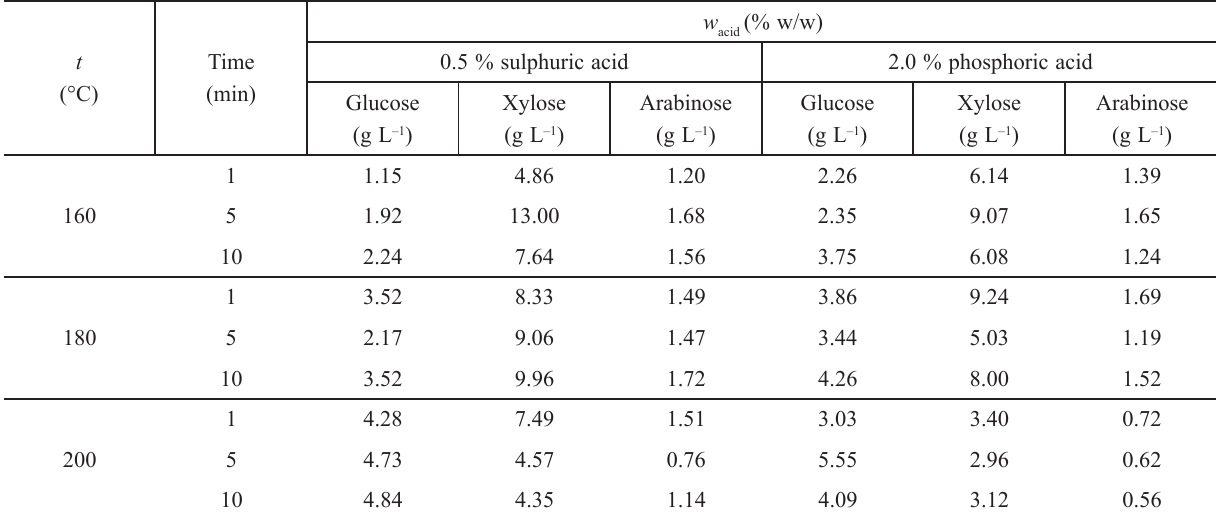
Table 1 – Concentrations of monomeric sugars in the liquor wheat straw hydrolysate after dilute acid pre-treatment in the HPR